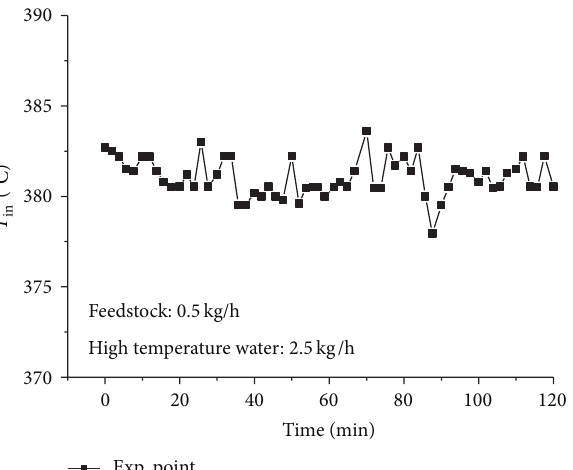
Figure 4: The variation of fluid temperature at the reactor inlet with time (large flow high temperature